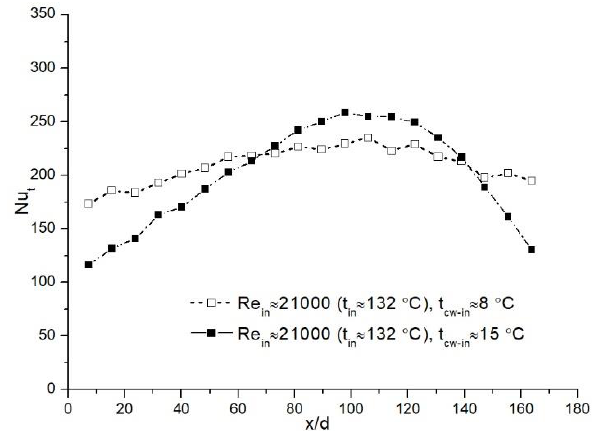
Figure 14. Distribution of the Nu t in the heat exchanger at Re in ≈ 21,000 and at different cooling water inlet temperatures.